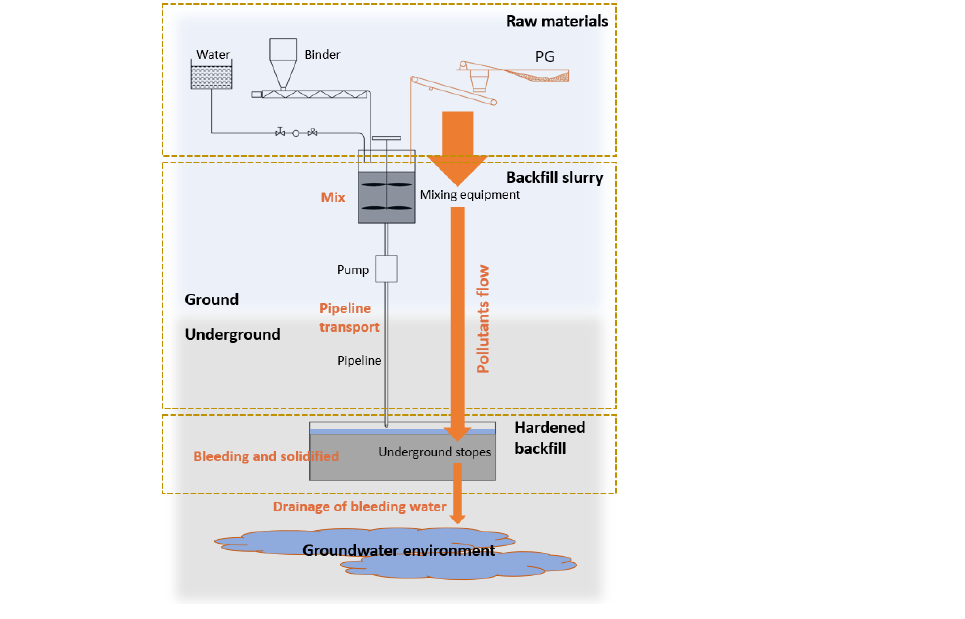
Figure 1. How pollutants are released into the surrounding environment via bleeding water.